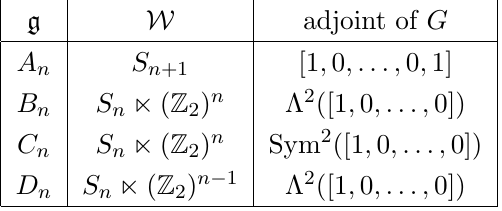
Table 1 . Classical algebras and their Weyl